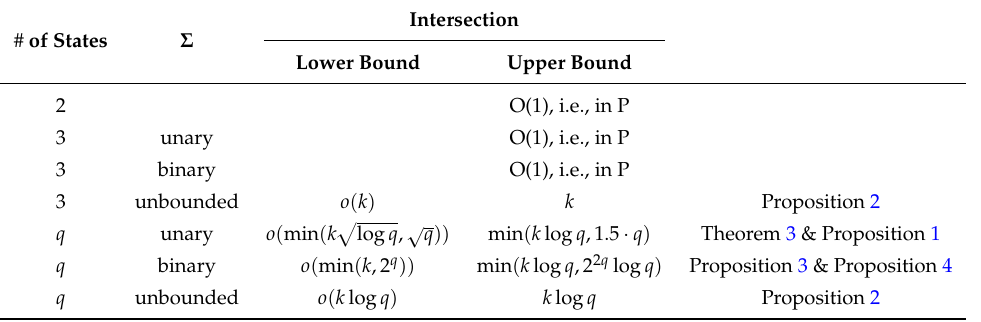
Table 2. Intersection; functions refer to exponents of bounding functions.